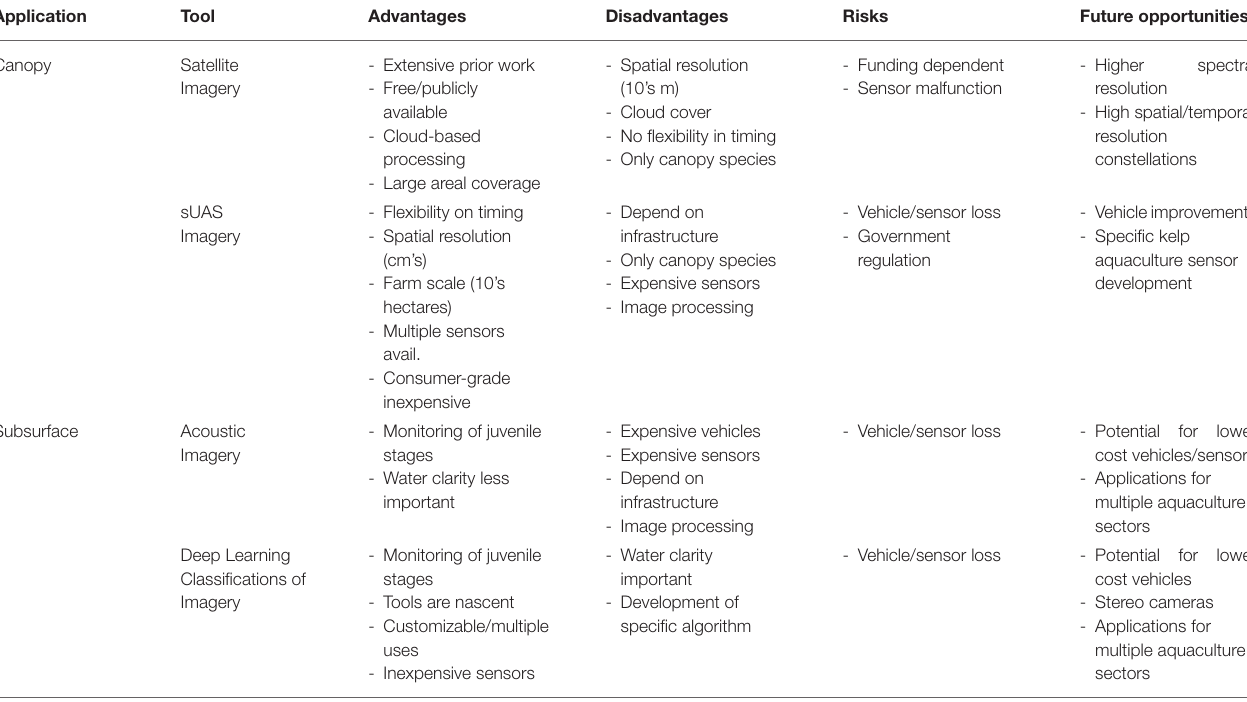
TABLE 3 | The advantages, disadvantages, risks, and future opportunities of various remote sensing technologies applicable to offshore kelp aquaculture